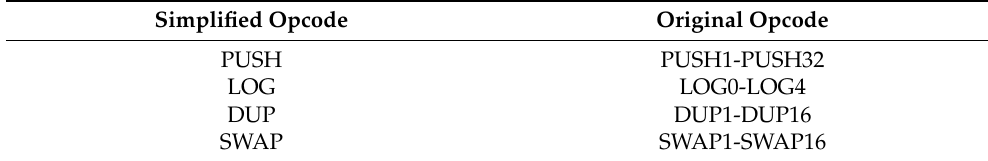
Table 3. Simplified Table 3 . Simplified opcode.